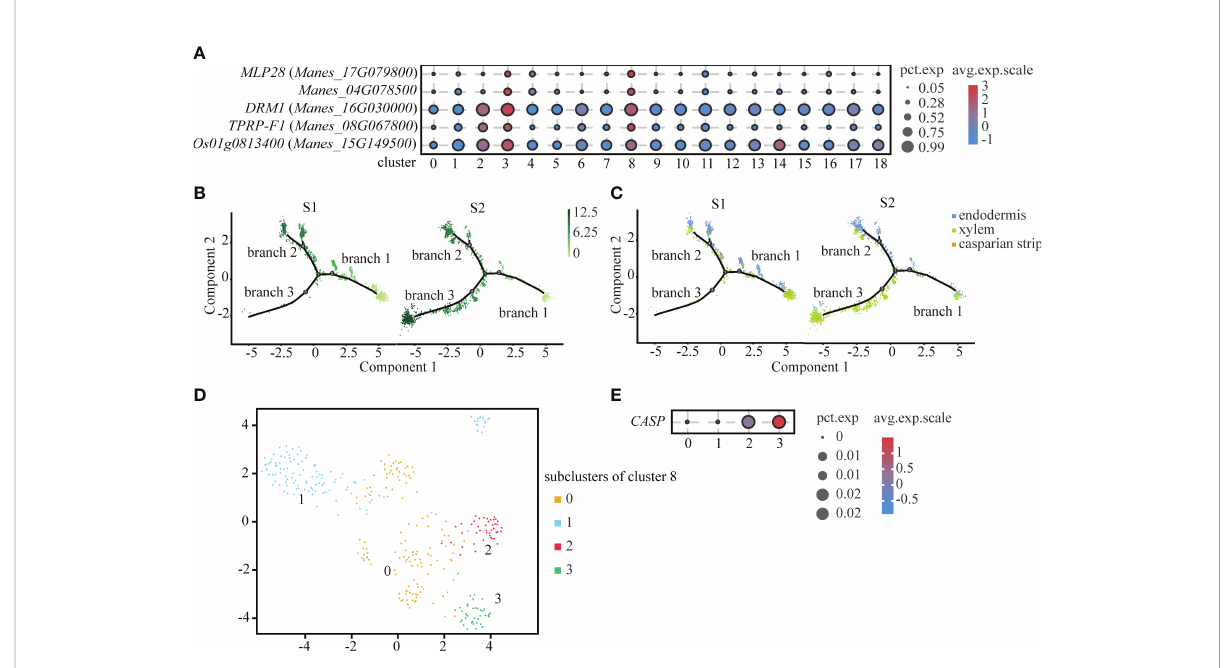
FIGURE 4 Differentiation Trajectory of Casparian strip. (A) Expression of signi fi cantly up-regulated genes in cluster 3 (endodermis) and cluster 8. Clusters 0 to 18 are classi fi ed according to cell-by-cell correlation. The cell types corresponding to each cluster are listed in the Supplemental Table 2. The dot size indicates the fraction of cells in each cluster expressing a given gene, and the color indicates the level of signi fi cation up-regulated genes exhibit the preferential expression in corresponding cluster. (B) Pseudotime analysis using monocle 2 for single-cell transcriptome in the endodermis, xylem and casparian strip revealing the differentiation trajectory. Each dot indicates a single cell. Different color on the dots indicates the pseudotime score. (C) Cell types labeled on the differentiation trajectory for S1 and S2, respectively. (D) UMAP exhibition of 4 subclusters after the subcluster analysis of cluster 8. Each dot indicates a single cell. (E) Expression abundance of 4 subcluster of cluster 8. The dot size indicates the fraction of cells in each cluster expression the given gene, and the color denotes the level of marker genes exhibit the preferential expression in corresponding